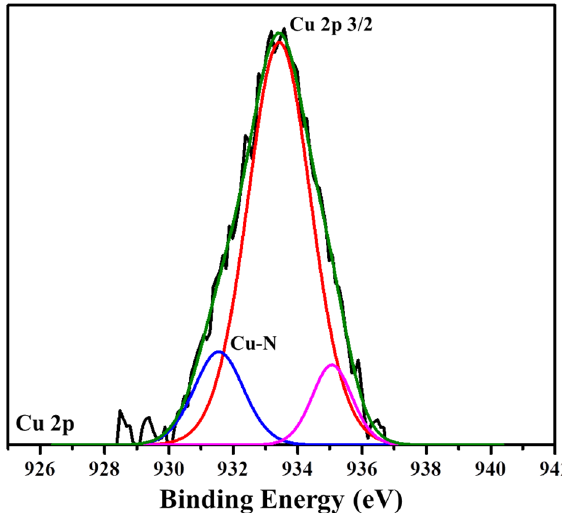
Figure 10. Deconvoluted spectra of Cu2p of Cu 3 N.